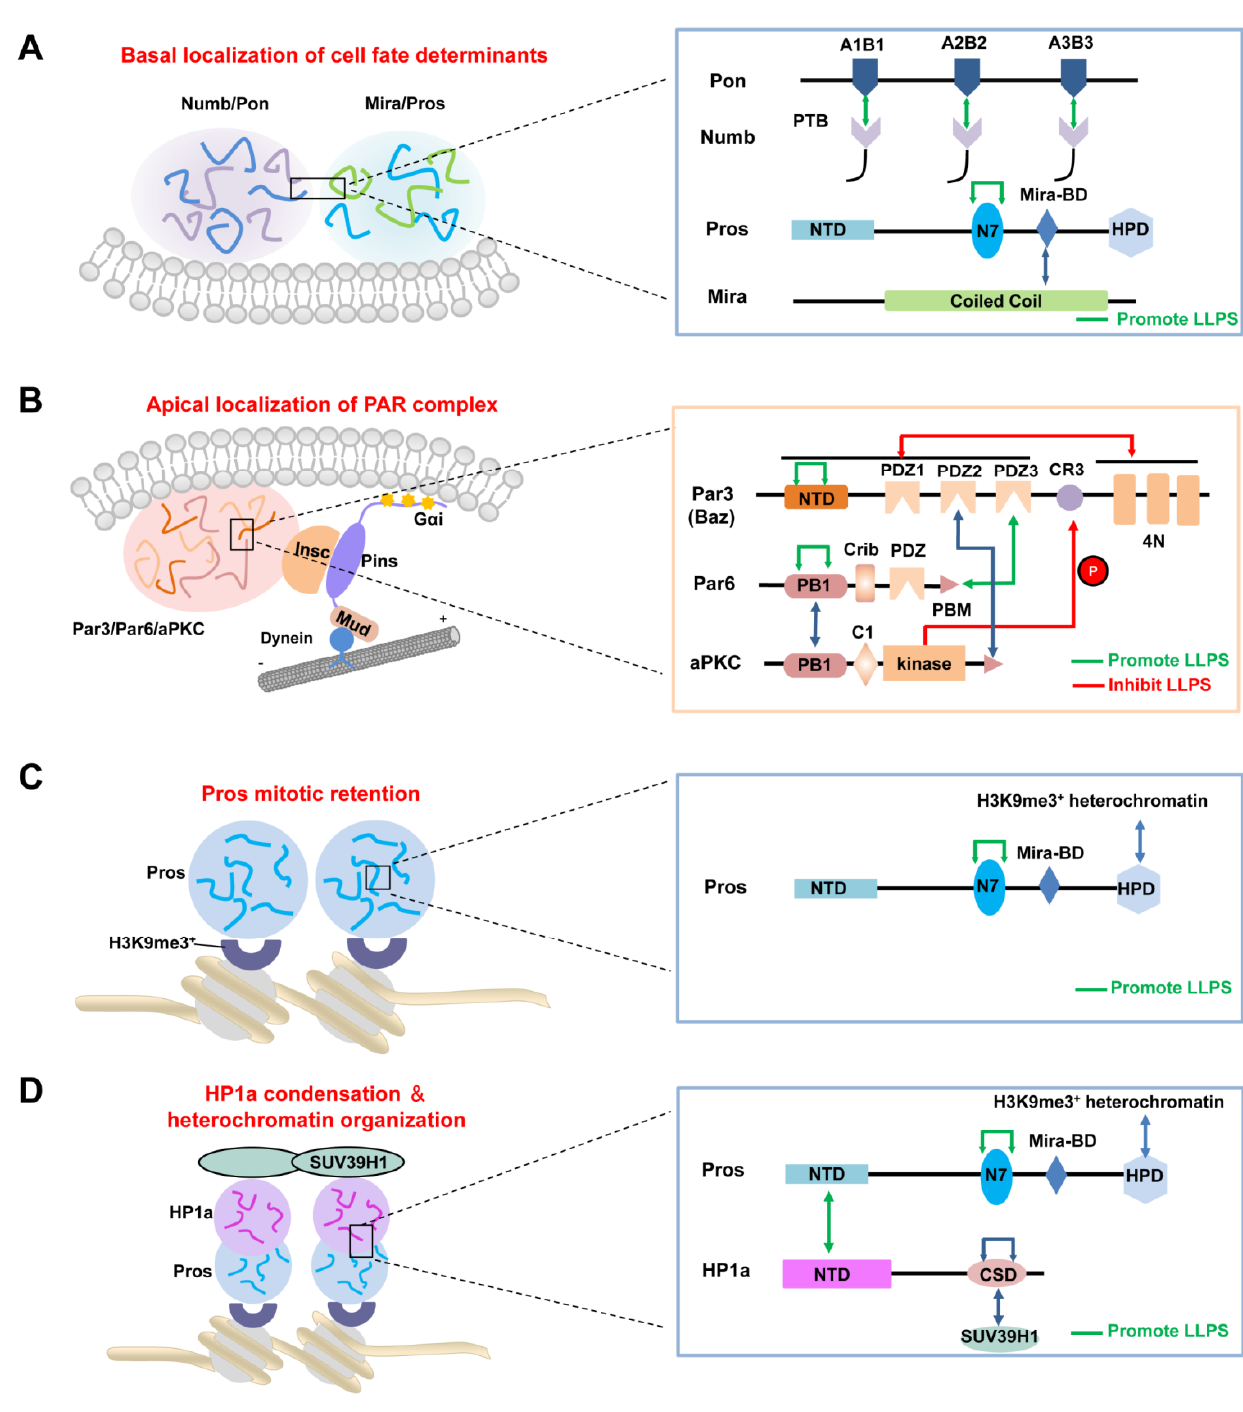
Figure 2. Polarity cues, including the PAR complex, Numb–Pon complex, and Pros with its various binding partners, play essential roles in different stages of asymmetric division of Drosophila NBs via LLPS. ( A , B ) The basal ( A ) and apical ( B ) protein condensates during ACD of NBs. ( C ) The mitotic retention of Pros at H3K9me3 + heterochromatin regions of chromosomes in mitotic GMCs via its LLPS. ( D ) Pros mediates HP1 condensation and thus drives the condensation and expansion of the H3K9me3 + heterochromatin regions in the newly generated neurons. The above proteins undergo LLPS spatiotemporally through multivalent interactions, which involve specific domain-domain recognition and self-oligomerization.